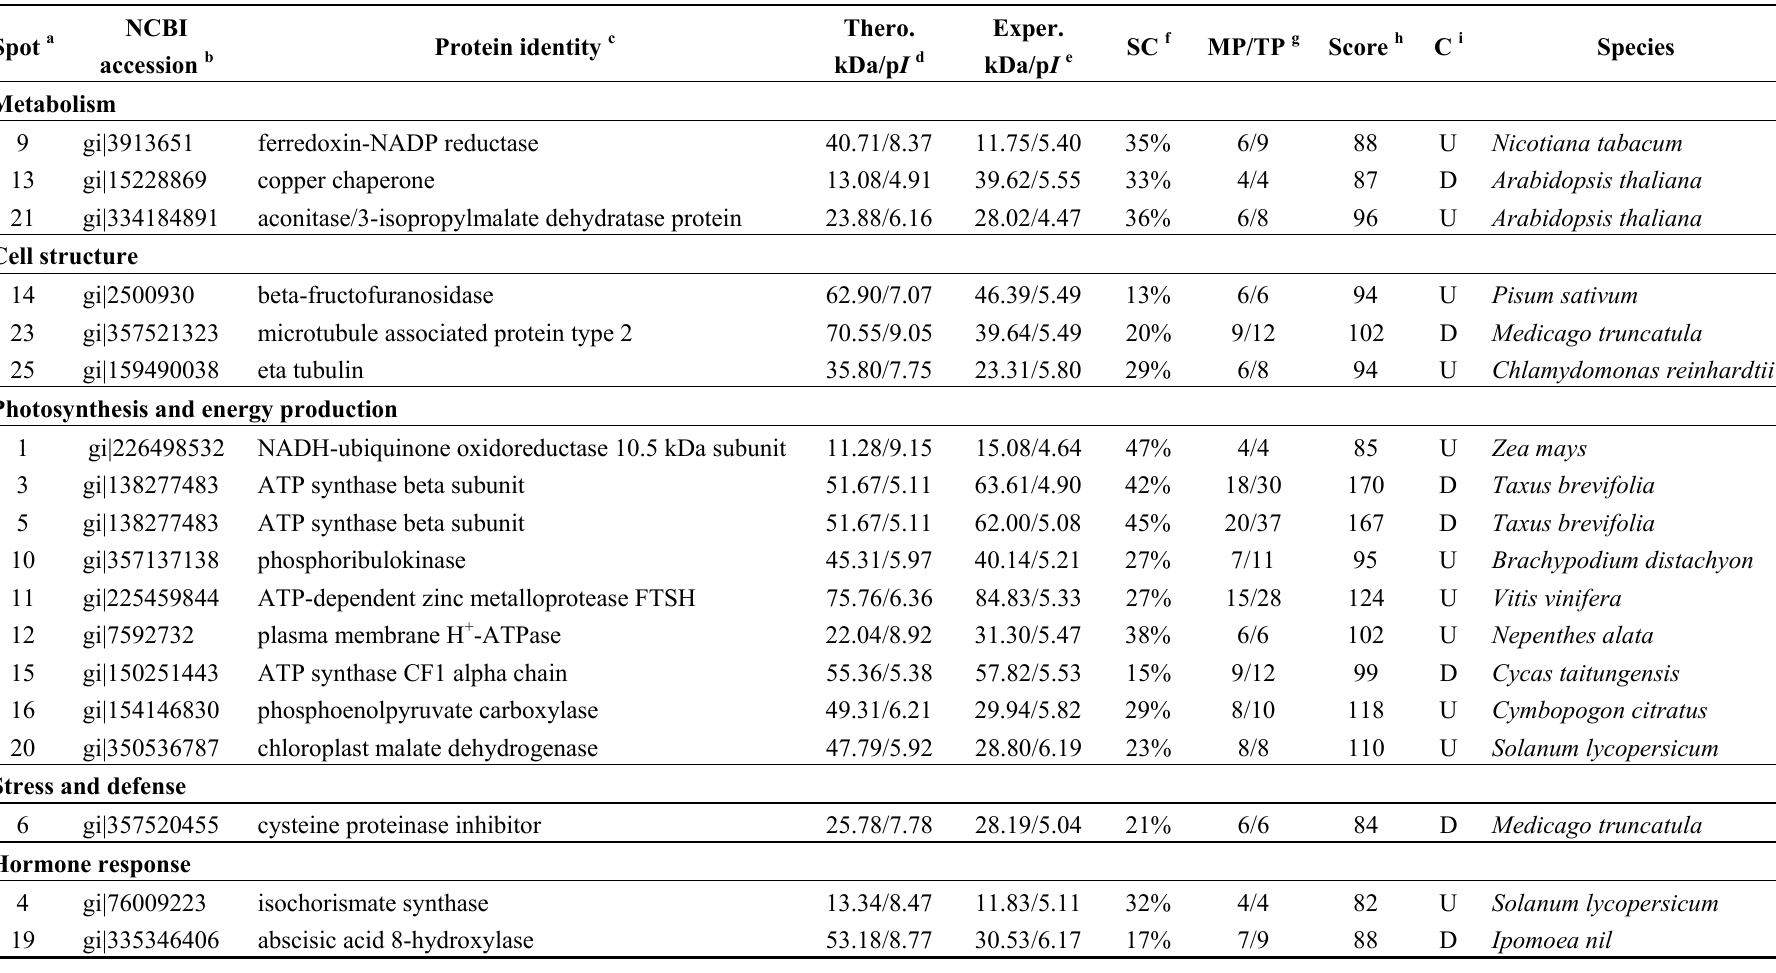
Table 2. Identification of differentially expressed proteins using 2-DE and mass spectrometry analysis in Taxus wallichiana var .mairei . Spot